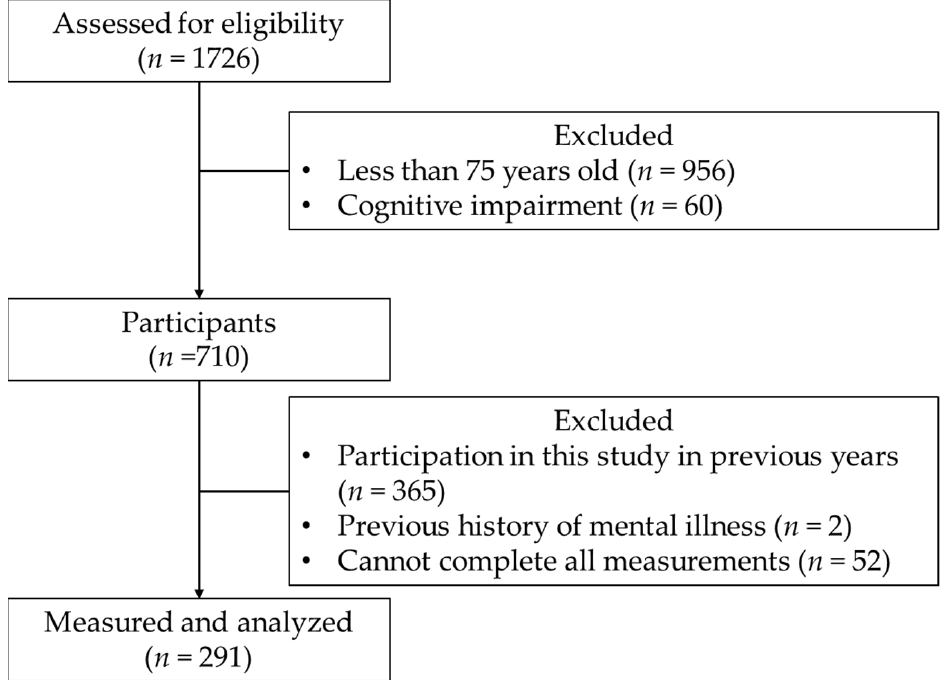
Figure 1. Flowchart of the selection process of the study participants.